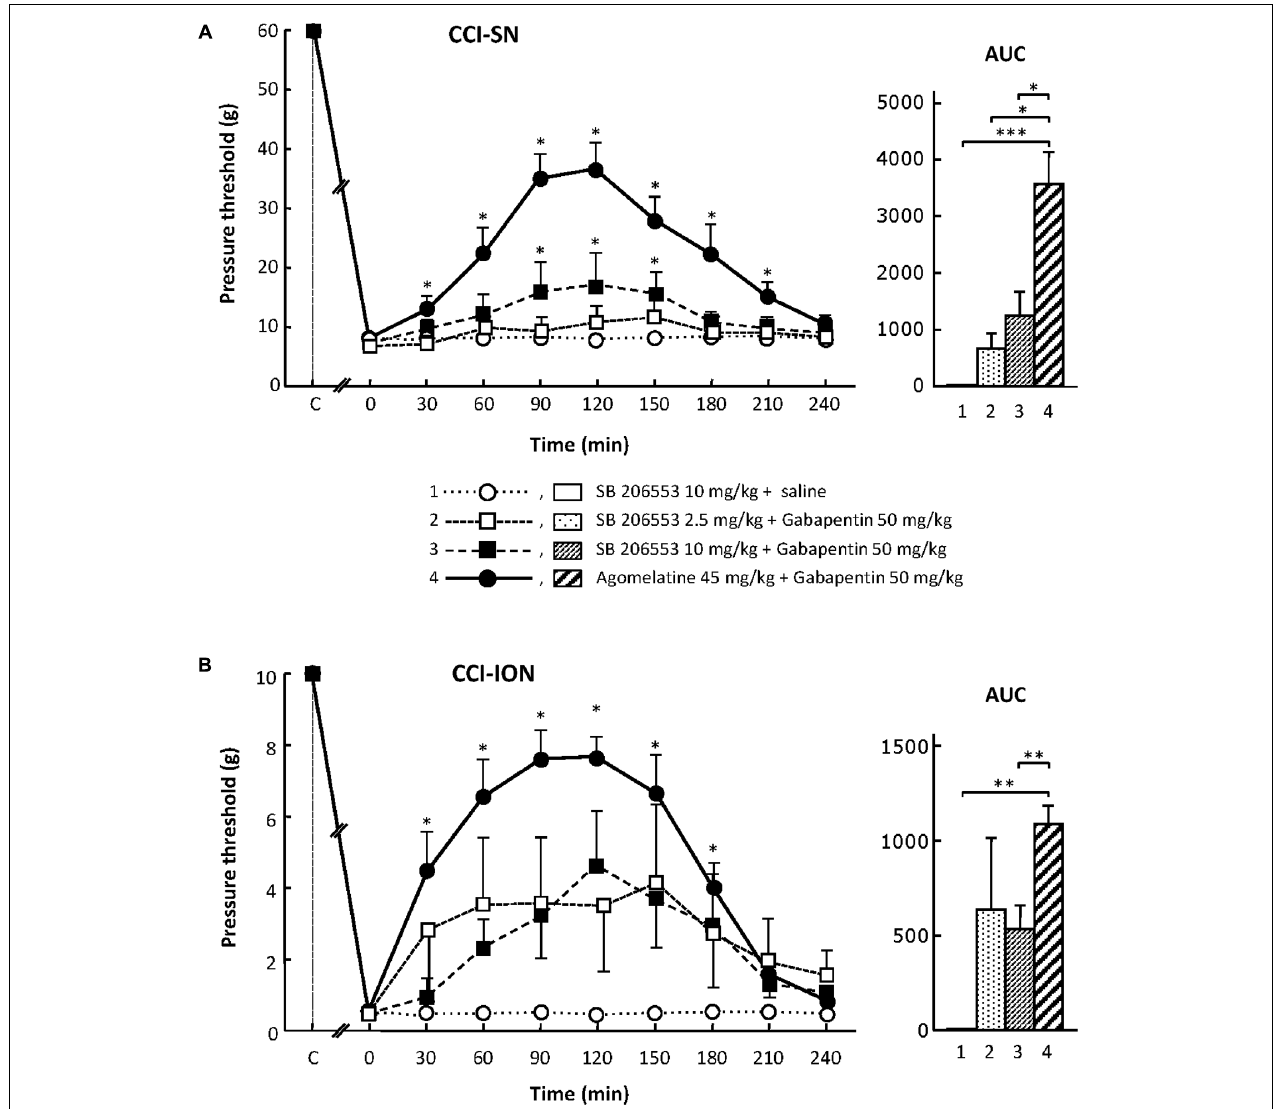
FIGURE 3 | Effects of SB 206553 alone or co-administered with gabapentin on mechanical allodynia in CCI-SN (A) and CCI-ION (B) rats. Comparison with the anti-allodynic effect of ‘agomelatine + gabapentin.’ Left panels: SB 206553 (2.5 or 10 mg/kg) + saline, SB 206553 (2.5 or 10 mg/kg) + gabapentin (50 mg/kg), agomelatine (45 mg/kg) + gabapentin and/or respective vehicles (saline, HEC) were injected i.p. 2 weeks after nerve ligation. Pressure threshold values (as g) were determined as described in the legend to Figure 1 . Each point is the mean ± SEM of n independent determinations. ∗ P < 0.05, compared with pressure threshold values determined just prior to drug injection (0 on abscissa), one way ANOVA with repeated measures, Dunnett’s test. C on abscissa: intact healthy rats before surgery. In both CCI-SN (A) and CCI-ION (B) rats, ‘saline+HEC’-treated groups were also included, but, for the sake of clarity, corresponding data are not represented as they superimposed with those obtained in rats treated with S206553 plus saline. Right panels: AUC values calculated from the respective time-course curves: (1) SB 206553 + saline [ n = 6 (A) , n = 6 (B) ]; (2) SB 206553 (2.5 mg/kg) + gabapentin ( n = 6/6); (3) SB 206553 (10 mg/kg) + gabapentin ( n = 6/13); (4) agomelatine + gabapentin ( n = 8/6). A- CCI-SN: one way ANOVA [ F (3,22) = 10.97, P < 0.0001] followed by Tukey’s test ( ∗ P < 0.05, ∗∗∗ P < 0.001); B- CCI-ION: one way ANOVA [ F (3,27) = 6.972, P = 0.0013] followed by Tukey’s test ( ∗∗ P <